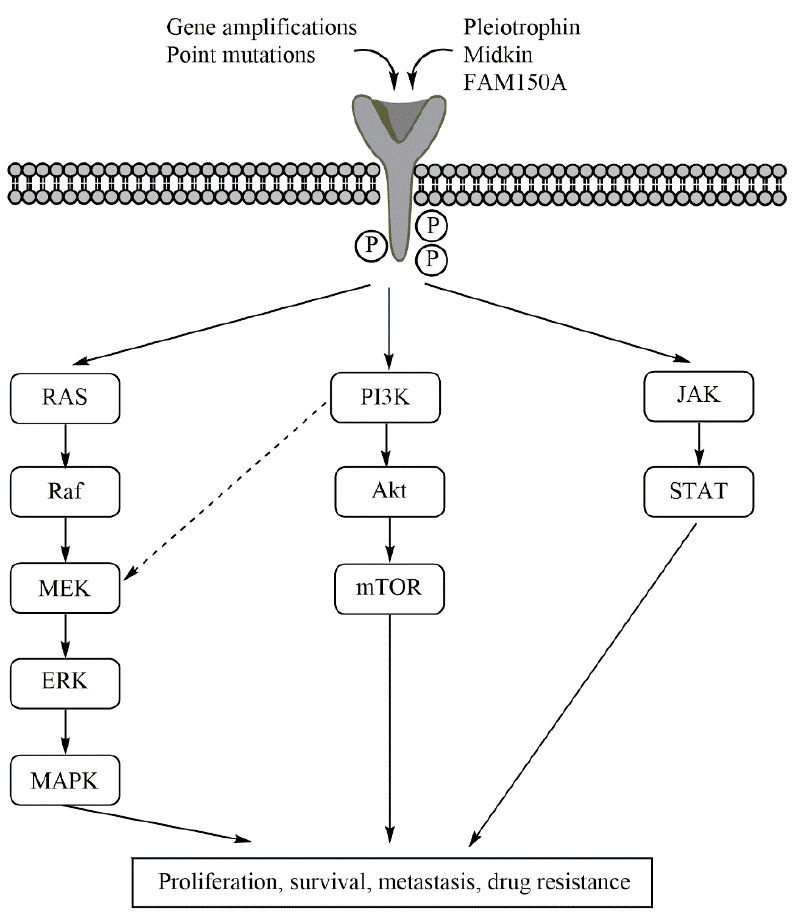
Figure 2. The downstream ALK activation pathways. ALK is either activated by its ligands pleitro- phin, midkin, and FAM150A, or by ALK aberrations. The figure highlights the pathways activated in aberrant ALK , where these pathways also contribute to drug evasion effects. Upon ALK auto-phosphorylation, the RAS/MAPK, PI3K/Akt/mTOR, and JAK/STAT pathways are activated. Signalling through these pathways is correlated with increased cancer cell proliferation, decreased cell apoptosis, metastization, and drug resistance. The interconnection between the RAS/MAPK and PI3K/Akt/mTOR pathways is also indicated.